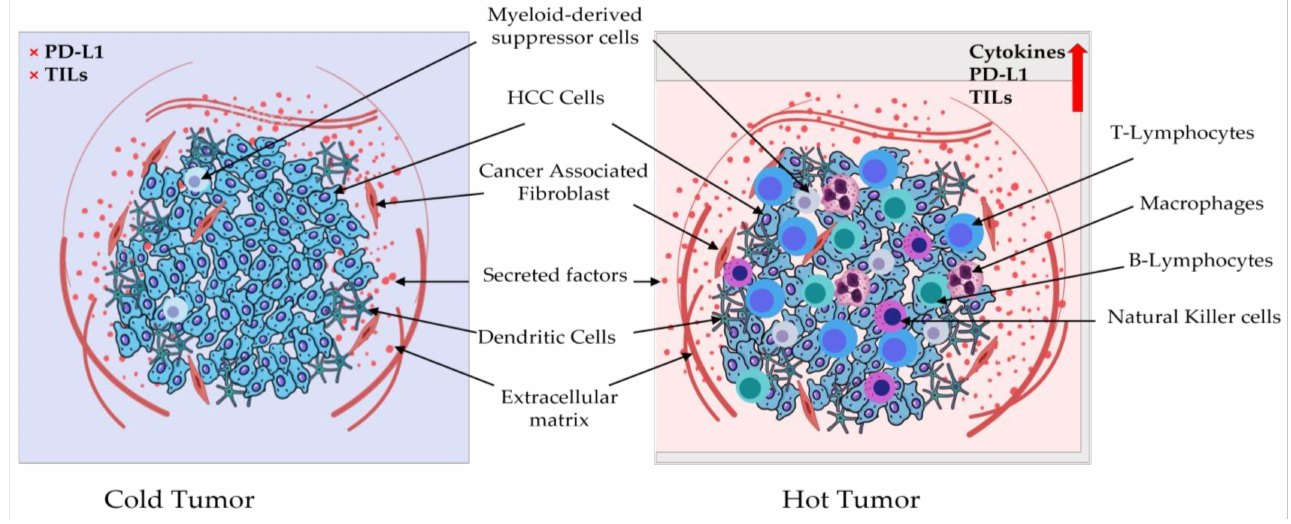
Figure 5. Schematic diagram representing the tumor microenvironment in hepatocellular carcinoma hot vs. cold tumor. Hot (T-cell-inflamed) tumors have significant immunological activity and significant T-cell infiltration, whereas cold (non-T-cell-inflamed) tumors are devoid of inflammation and T cells. A high expression of PDL-1, TILs and cytokines is typically associated with a hot tumor. They contain more CD8+ lymphocytes and tumor-associated macrophages (TAMs) than myeloid- derived suppressor cells (MDSCs) and cancer-associated fibroblasts (CAFs). In contrast, the TME from cold tumors is linked with low CD8+ and elevated